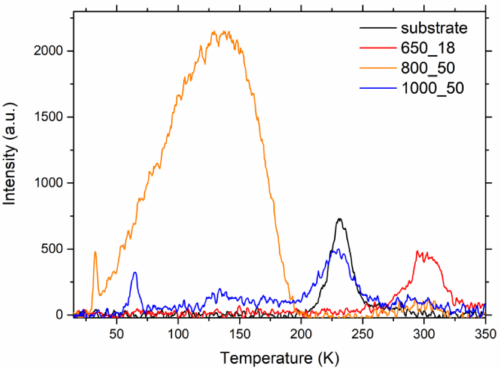
Figure 12. Low-temperature thermoluminescence of sapphire substrate, 650_18 sample, 800_50 sample, and 1000_50 sample.